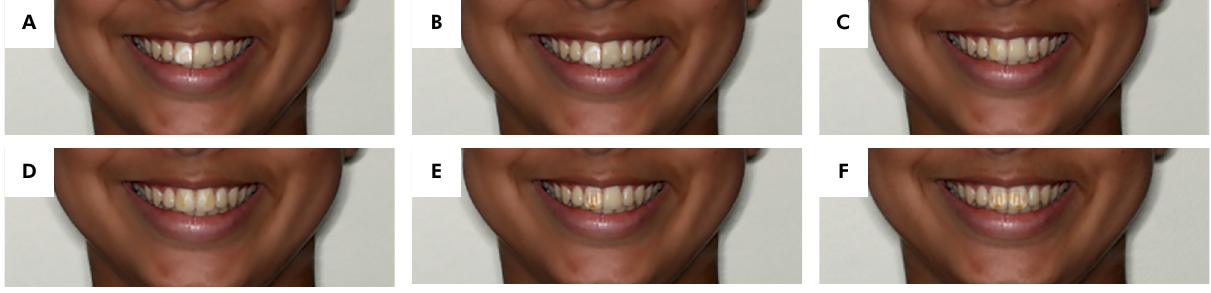
Figure 1. Opacity in the boy: A) Unilateral white opacity; B) Bilateral white opacity; C) Unilateral yellowish opacity; D) Bilateral yellowish opacity; E) Unilateral yellowish opacity + Enamel with loss of structure; F) Bilateral yellowish opacity + Enamel with loss of structure.